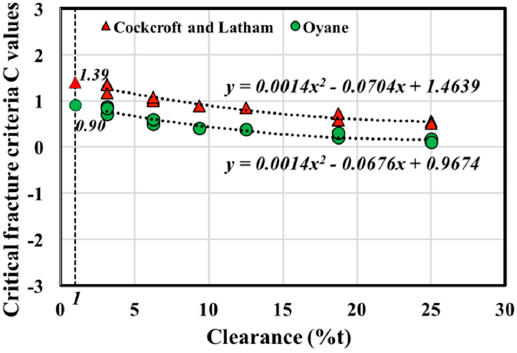
Figure 11. The values of critical ductile fracture criteria ( C ) for the Cockcroft-Latham and Oyane models obtained from polynomial equation for the clearance of 1 %t.